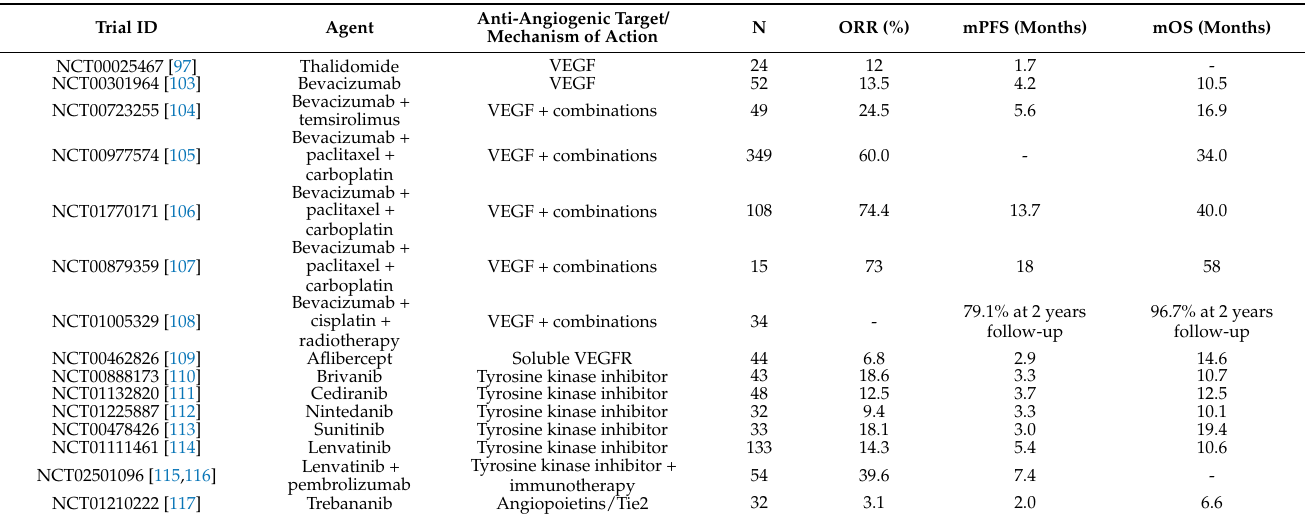
Table 1. Completed phase-II trials evaluating anti-angiogenic agents in recurrent/metastatic endome- trial cancer. ORR—objective response rate; mPFS—median progression-free survival; mOS—median overall